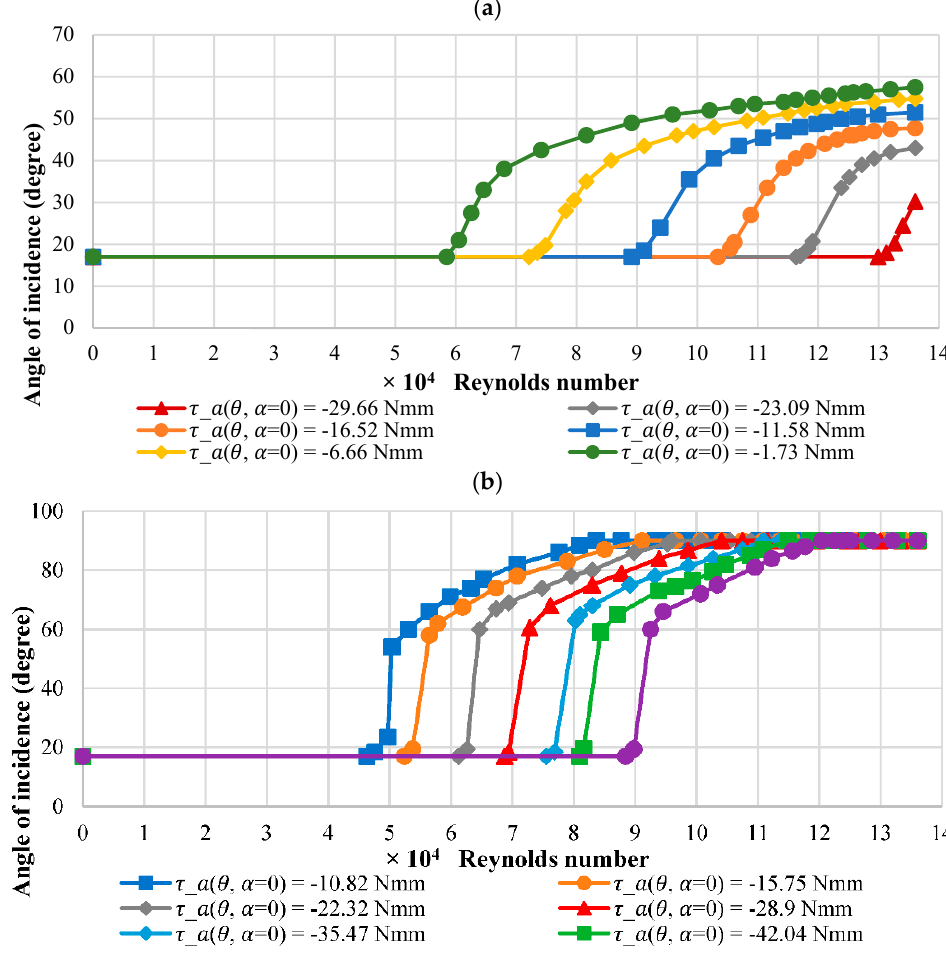
Figure 5. Response of the angle of incidence against flow velocity for ( a ) MP3 and ( b ) MP4 of NACA 0012.